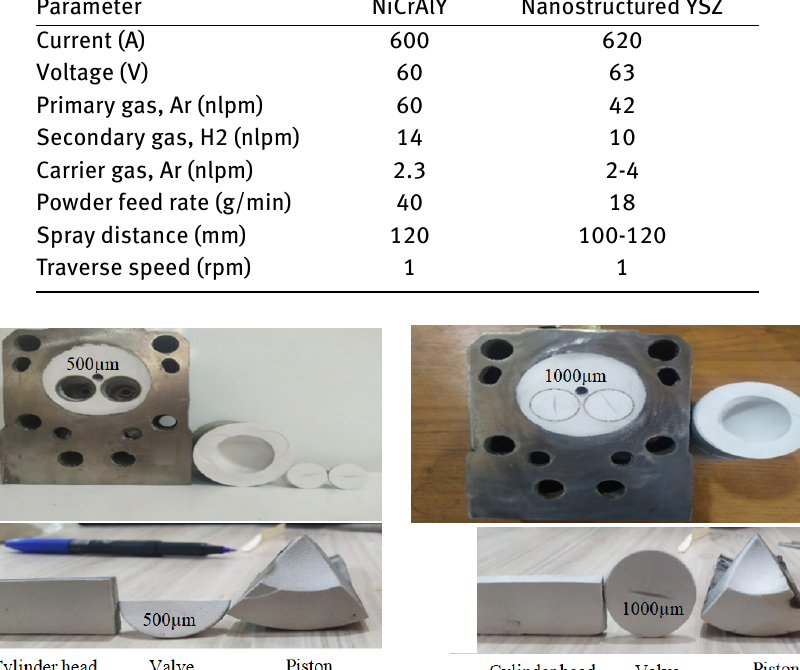
Figure 3: Diesel engine head of cylinder, valves, and piston top combustion chamber parts coat and bottom diesel engine coated